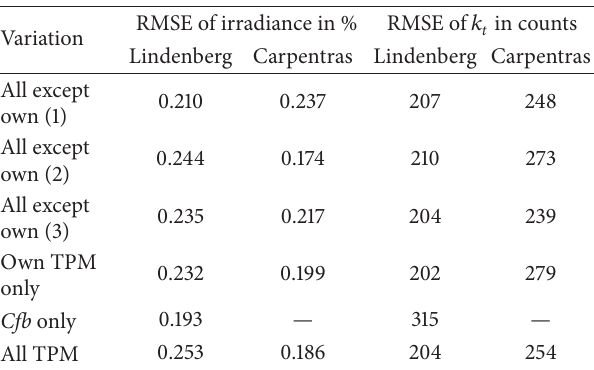
Table 5: Comparison of synthesis quality of the new algorithm as a function of input data for the locations of Lindenberg, Germany, 2005, and Carpentras, France,